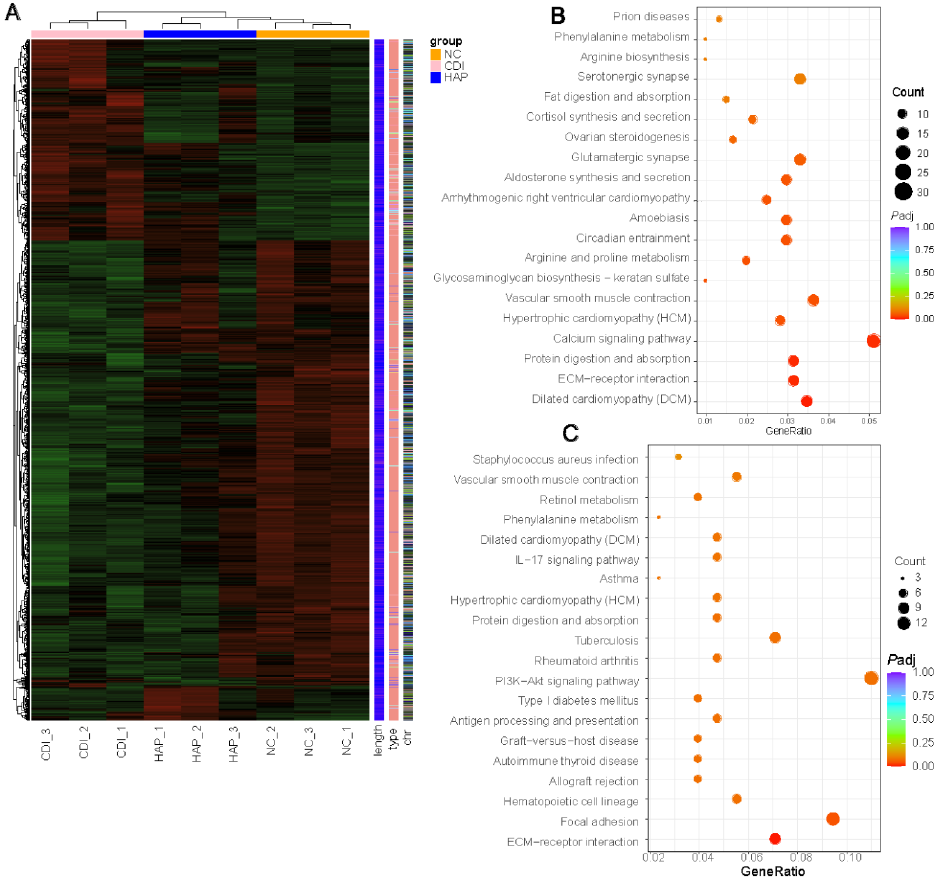
Figure 6. Partial reversal of transcriptional regulatory changes by apple polyphenol treatment. ( A ) Heatmap of differentially expressed genes among the 3 groups. ( B ) KEGG map of differentially expressed genes between CDI and NC groups. ( C ) KEGG map of differentially expressed genes between CDI and HAP groups. Circle size shows number of genes enriched in the pathway, and color scale represents p value.